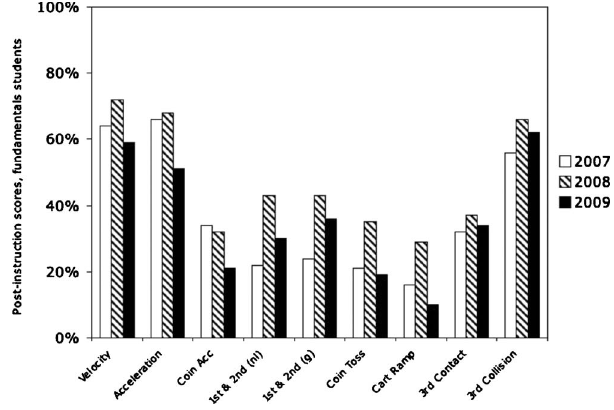
FIG. 6. Postinstruction scores for Fundamentals students, ex- posed to ILD methods of